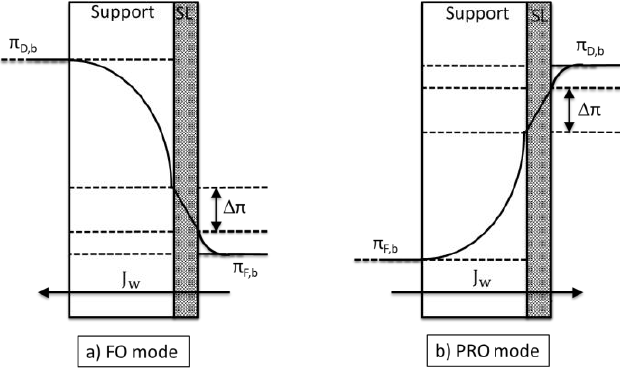
Figure 6. The orientation of support and selective layer (SL) in ( a ) FO mode (SL-FS), and ( b ) PRO mode (SL-DS).